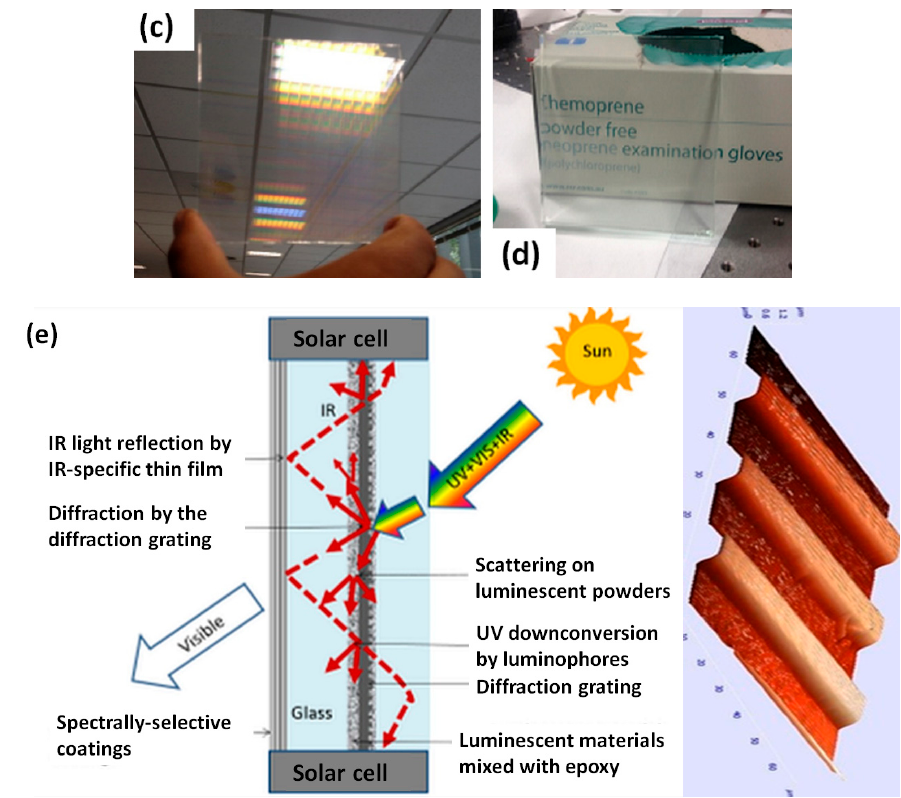
Figure 3. Components and structures used for constructing ClearVue PV window modules and their main properties. Graphics are reproduced from Reference [7] for system structure illustration